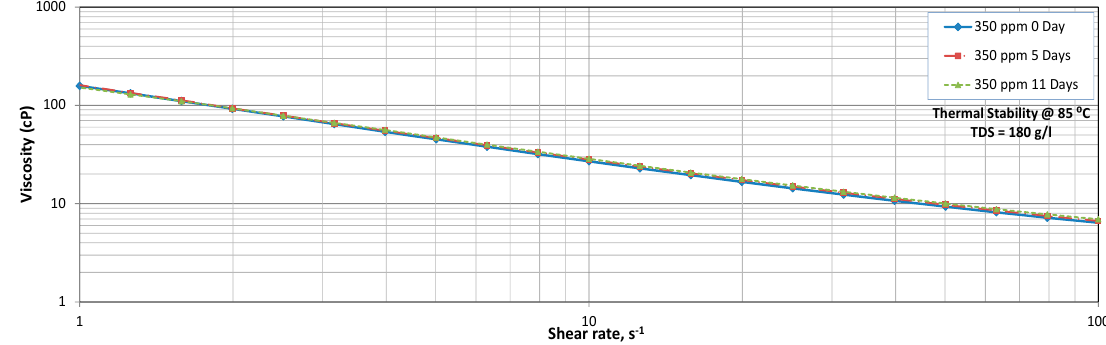
Figure 4. Effect of thermal exposure on biopolymer solution viscosity (SAMA).